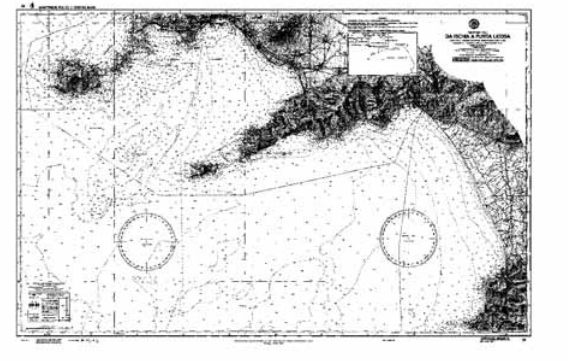
Fig. 1. The considered nautical